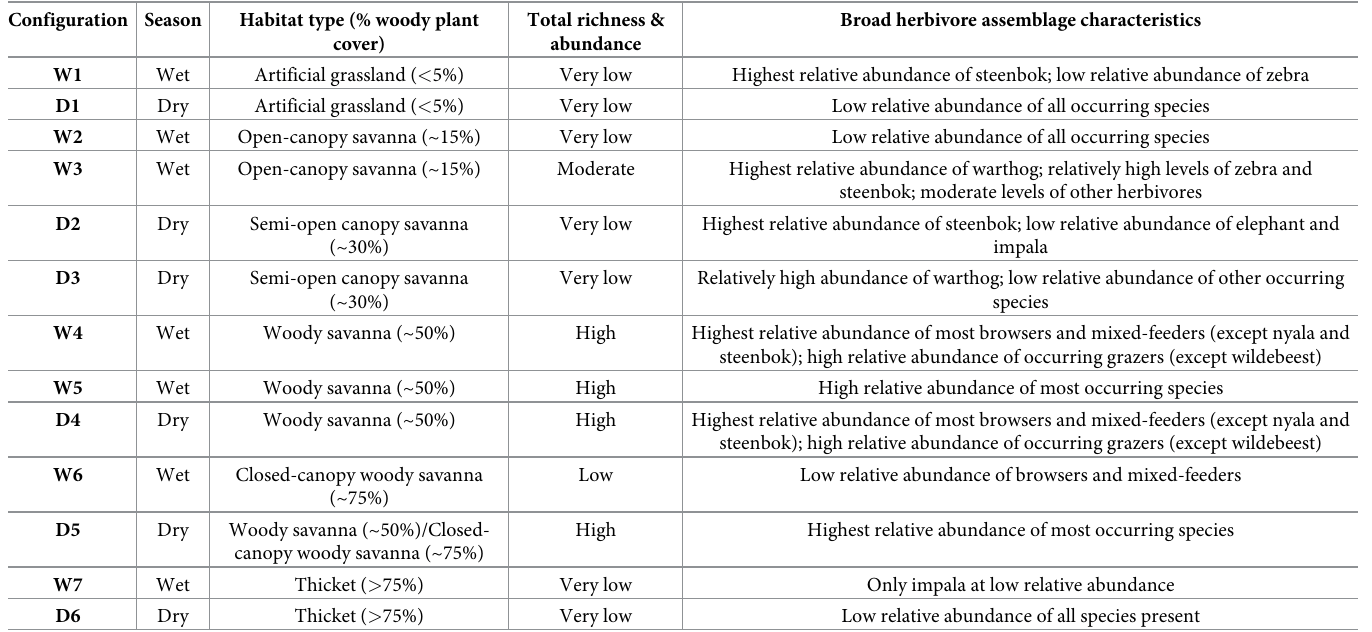
Table 1. Defining characteristics of each configuration. We list the habitat type in which a given configuration has the highest frequency of occurrence. Configuration